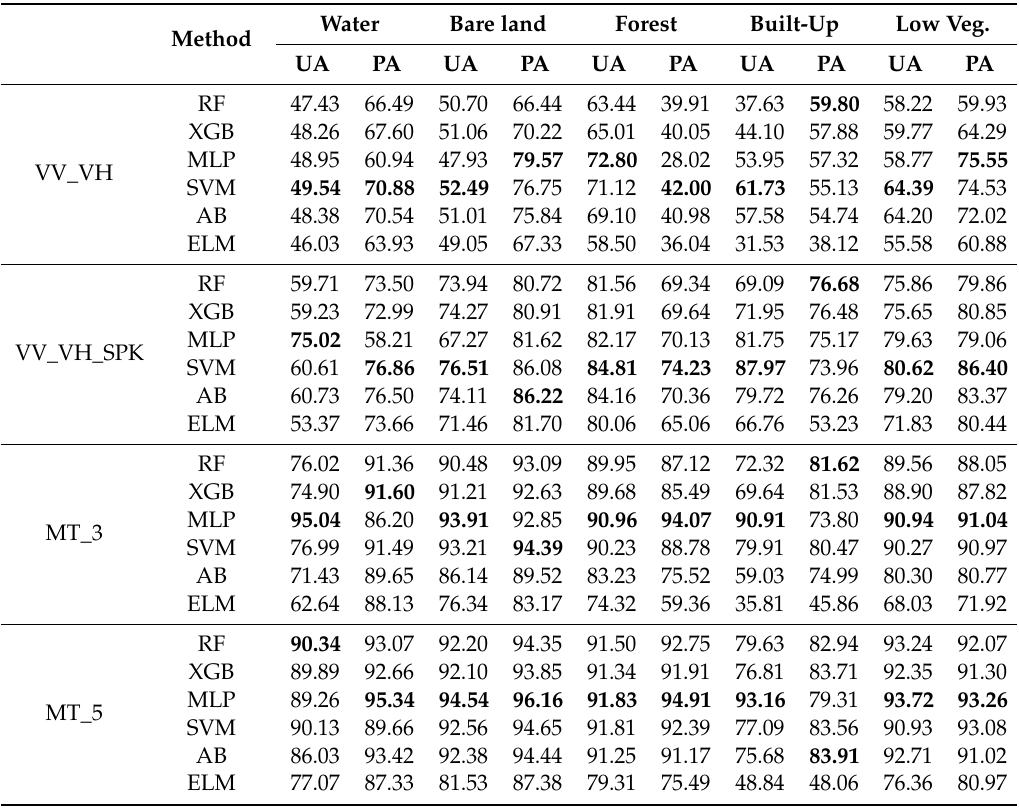
Table 4. The mean values of user’s accuracy (UA) and producer’s accuracy (PA) of individual land-cover (LC) classes in di ff erent classification scenarios using S1 imagery (the best UA and PA values for scenario are highlighted in